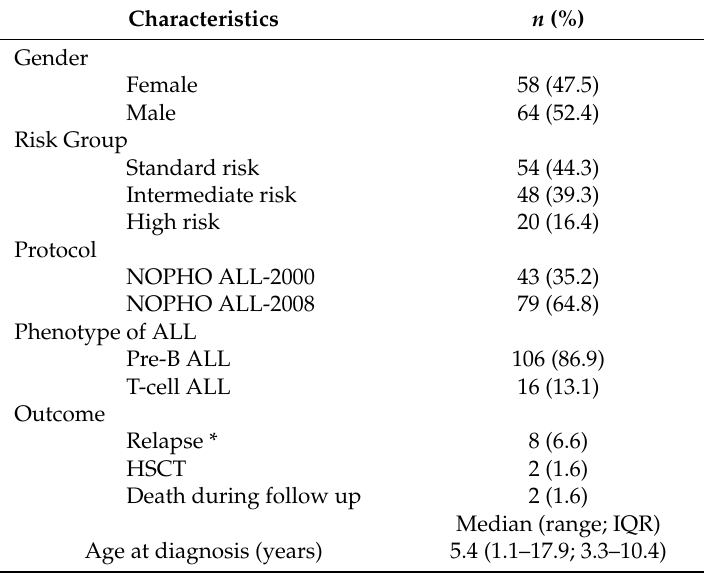
Table 1. Patient characteristics of the 122 included children treated for